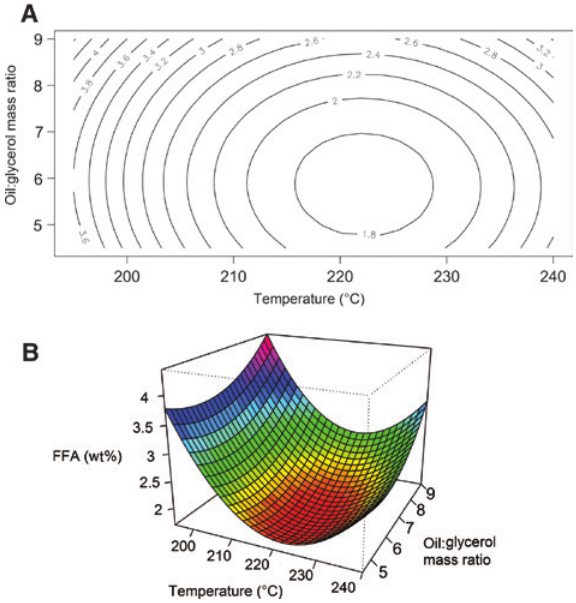
Figure 7: Influence of temperature and oil:glycerol ratio on free fatty acid (FFA) reduction: (A) the contour lines are of constant FFA concentration (%) and (B) perspective plot of the modeled